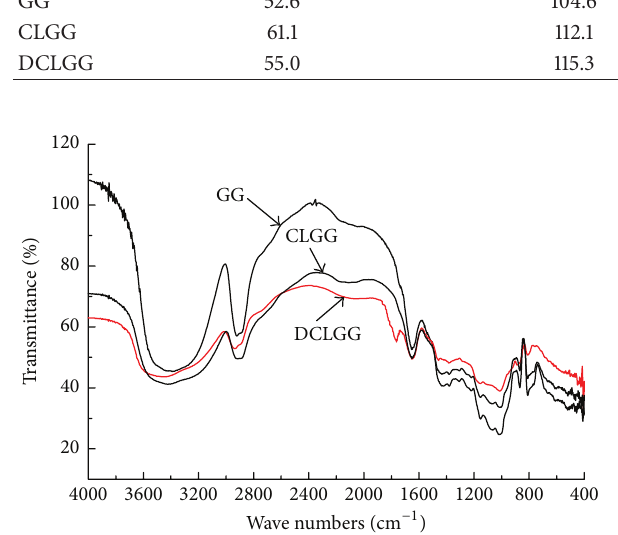
Figure 5: IR spectra of GG, CLGG, and DCLGG.